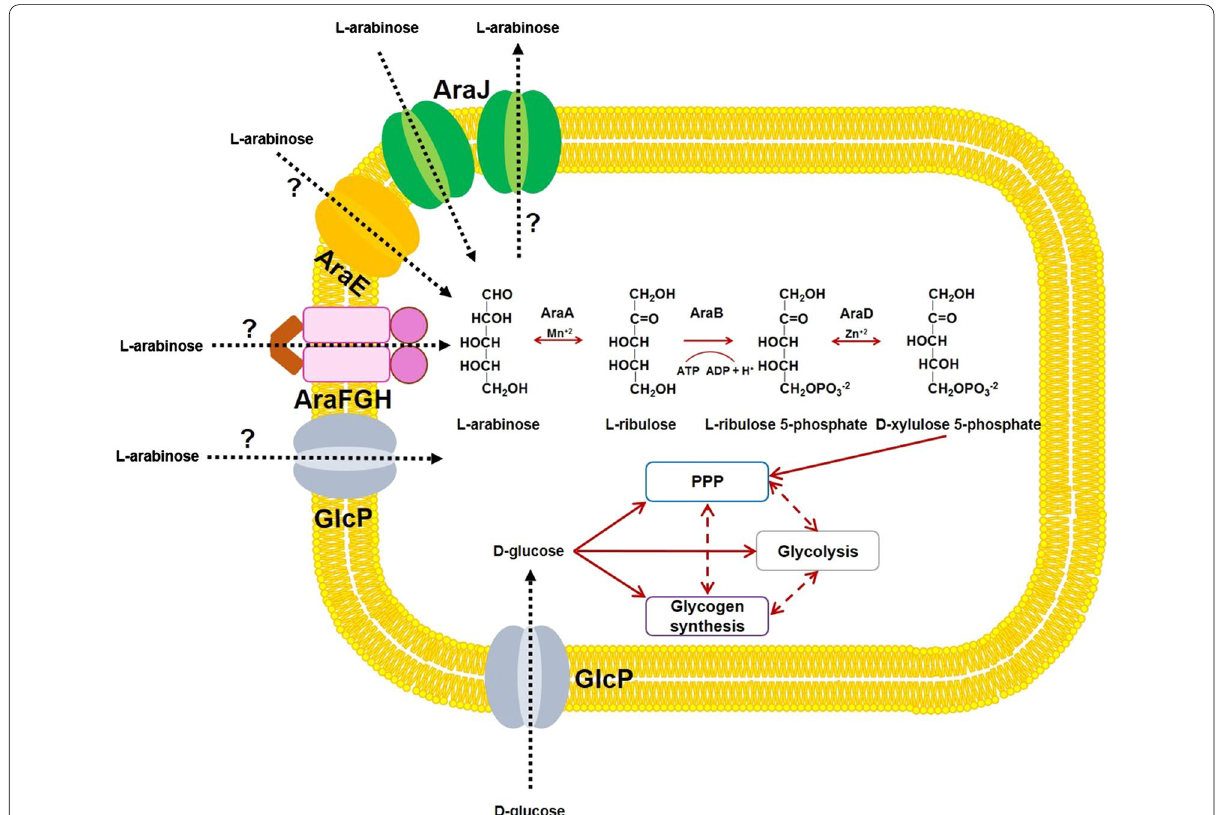
Fig. 1 Metabolic scheme for engineering Synechocystis strains. L-arabinose may enter the transformant strains by means of native transporter/s such as GlcP and heterologous transporters such as AraE, AraFGH and AraJ. Direction of entry and exit of sugars (established, indicated in this study and putative) is shown using dotted arrows. L-arabinose is converted to L-ribulose by L-arabinose isomerase (AraA) in the presence of manganese ions (Mn + 2 ). L-ribulose is phosphorylated to L-ribulose 5-phosphate (L-Ru5P) by the action of L-ribulokinase (AraB). L-Ru5P is converted by L-ribulose 5-phosphate 4-epimerase (AraD) in the presence of zinc ions (Zn + 2 ) to D-xylulose 5-phosphate (D-Xu5P), which enters the pentose phosphate pathway (PPP). Bidirectional arrows indicate a reversible reaction or connections between metabolic pathways through intermediates. Unidirectional arrows indicate a non-reversible reaction or the ability of a sugar or an intermediate to either enter or exit a pathway. Dashed arrows indicate the involvement of one or more intermediates. Question marks (?) indicate putative transport of L-arabinose. Other abbreviations: